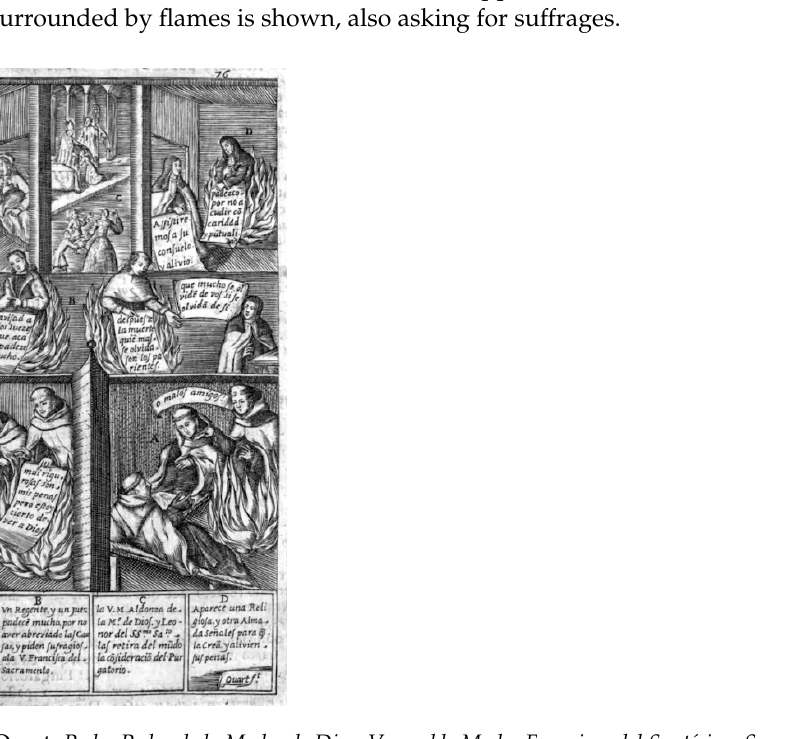
Figure 15. Quart. Padre Pedro de la Madre de Dios; Venerable Madre Francisca del Santísimo Sacramento y vecina de Puebla de los Ángeles . Francisco de la Cruz, Cinco palabras del apóstol San Pablo … p. 76.